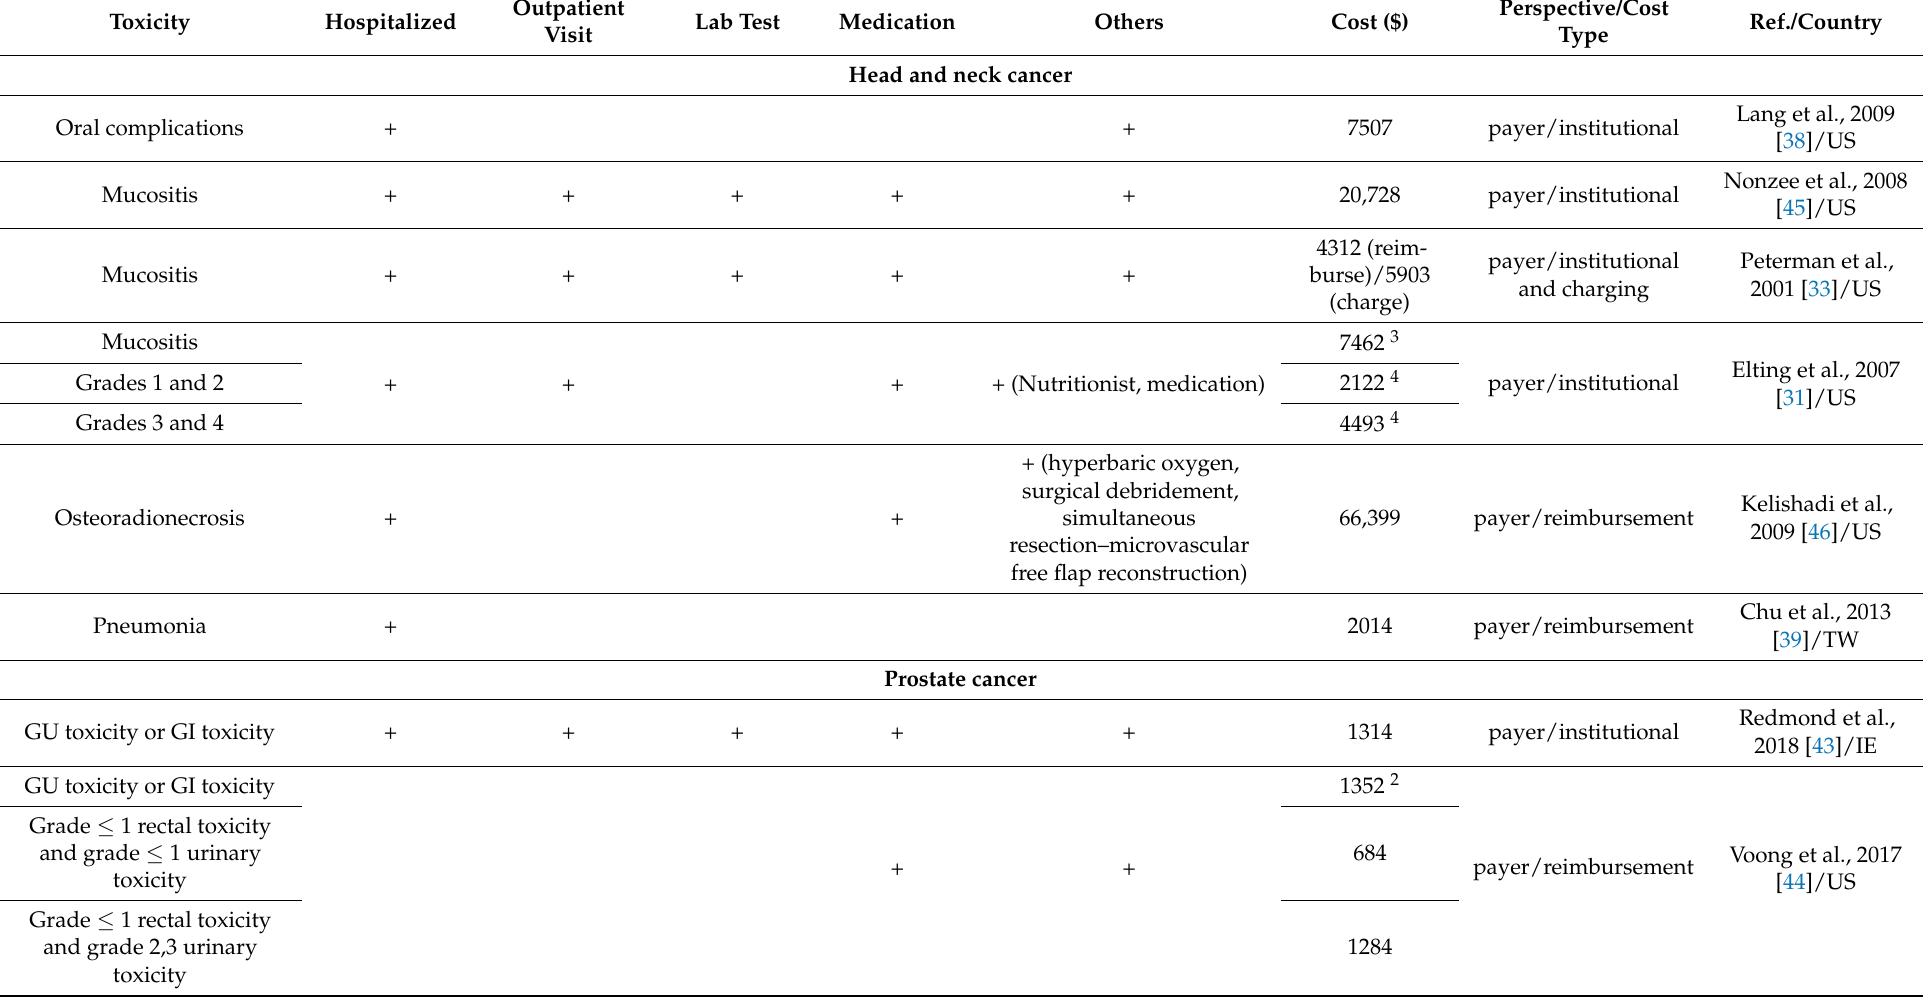
Table 4. Reported healthcare costs 1